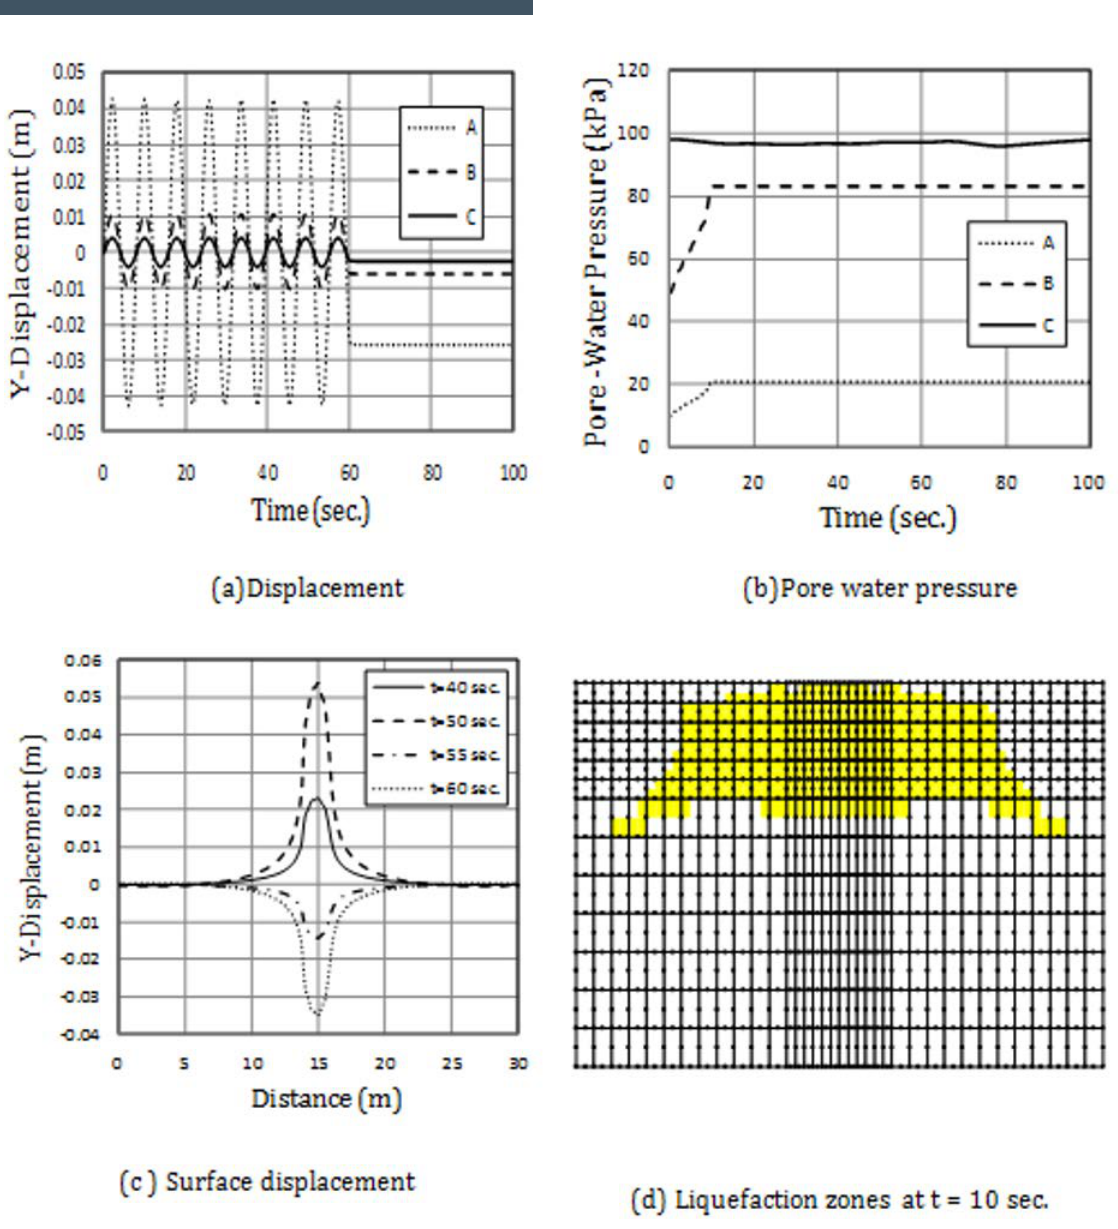
Figure 22. Dynamic response of the foundation to harmonic load, a